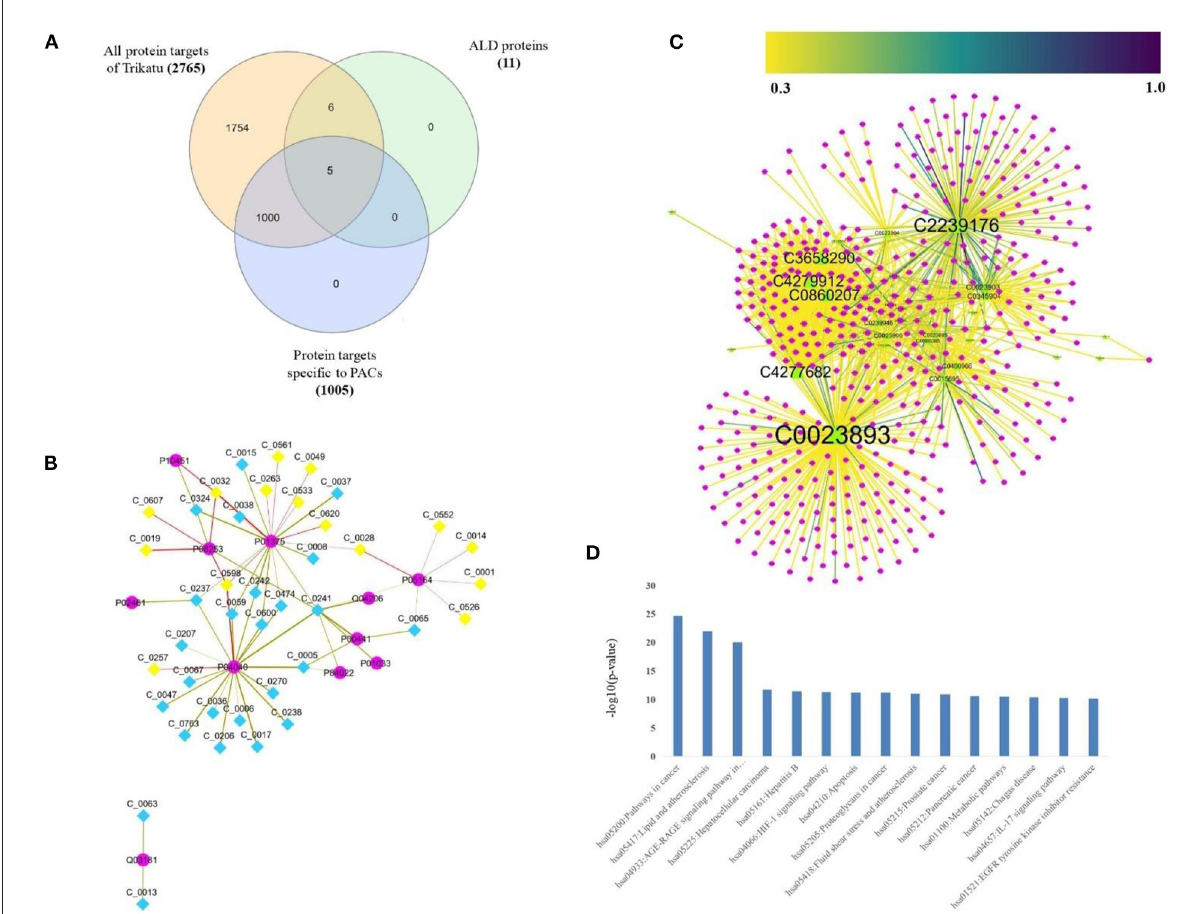
FIGURE5 Regulatory phytochemicals of TC in managing ALD. (A) Venn-diagram showing the distribution of protein targets of TC . (B) Alcoholic Liver Disease-specific Protein Target (ALD-PT) network comprising of 51 nodes and 63 edges, consisting the information of 11 ALD proteins (diamond nodes) and their 40 regulatory (pink circular nodes) PCs of TC . Among the 40 PCs, yellow highlighted nodes represent PACs. (C) Protein-disease association network, highlighting the regulatory role of 40 PCs via their 453 protein targets (pink circular nodes) toward 24 liver-associated disease terms (green triangular nodes). The size of the nodes varies according to their degree value in the network. The edge color of the protein-disease pair varies as per the DisgeNET score. (D) Pathway association of the 453 protein targets of 40 PCs of ALD-PT network, where X-axis represent the Human-pathway and Y-axis represent the –log10 ( P value). For the display only 15 highly enriched pathways based on P -value were selected, highlighting the major role of PCs in regulating cancer and signaling